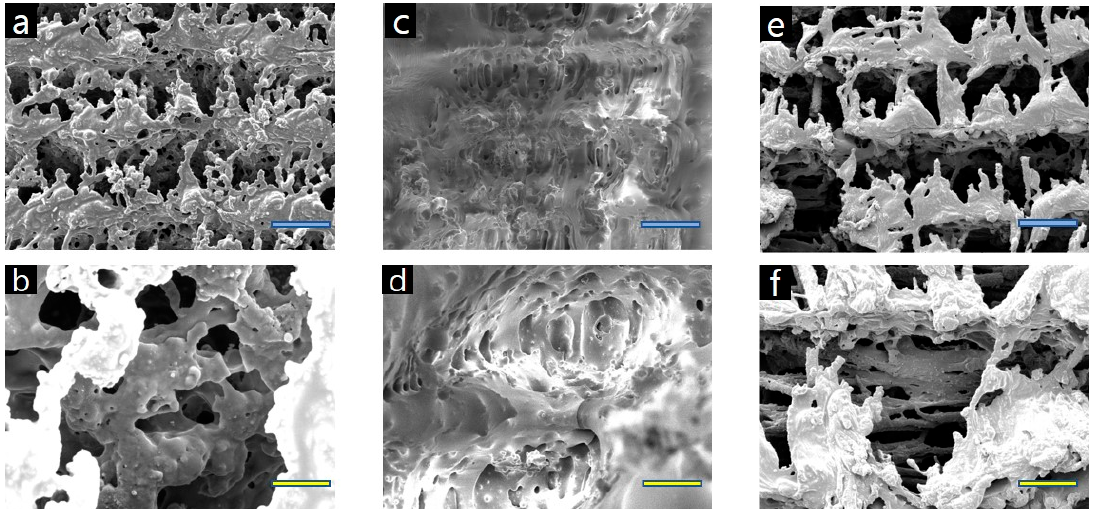
Figure 5. SEM images of wood surfaces carbonized by laser irradiation: ( a , b ) beech, ( c , d ) cork oak, ( e , f ) ash; blue scale bar: 100 µ m; yellow scale bar: 20 µ m.